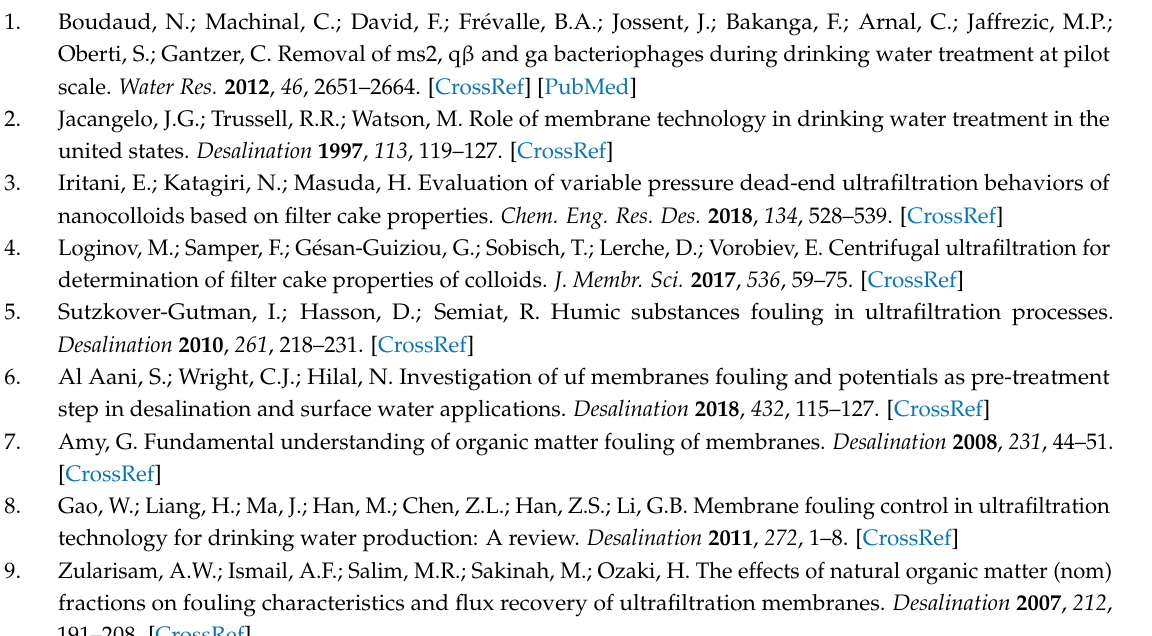
Table S1: Main properties of PAC, Figure S1: Schematic diagram of ultra-filtration sys, Figure S2: The optimization of the coagulation process, Figure S3: The optimization of the adsorption